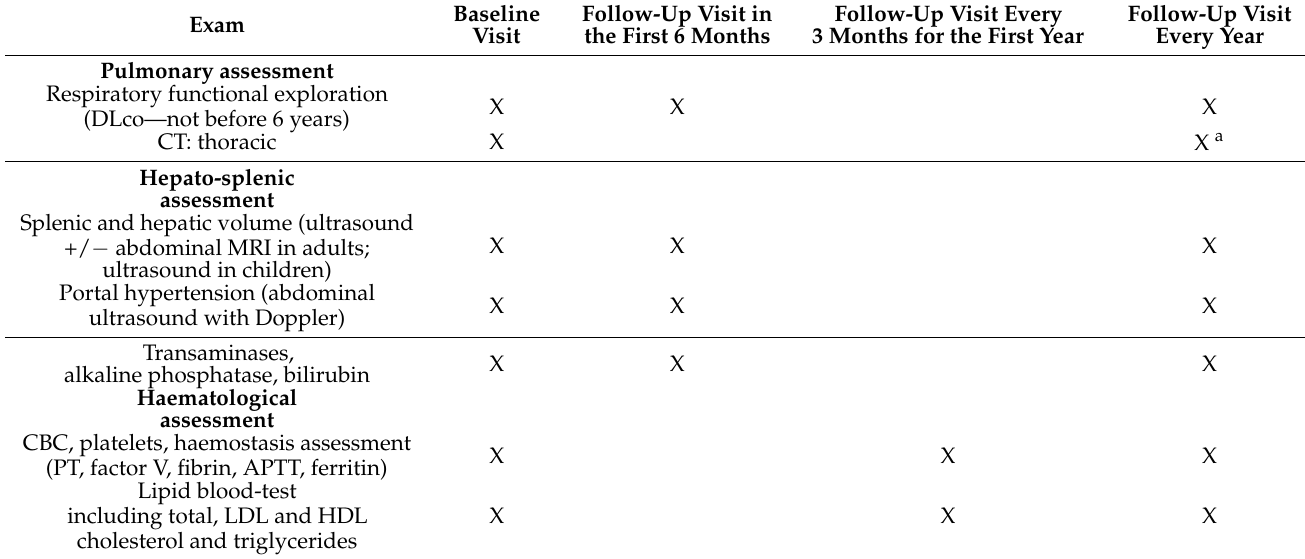
Table 2. Key monitoring parameters and frequency of assessments for patients with ASMD type B